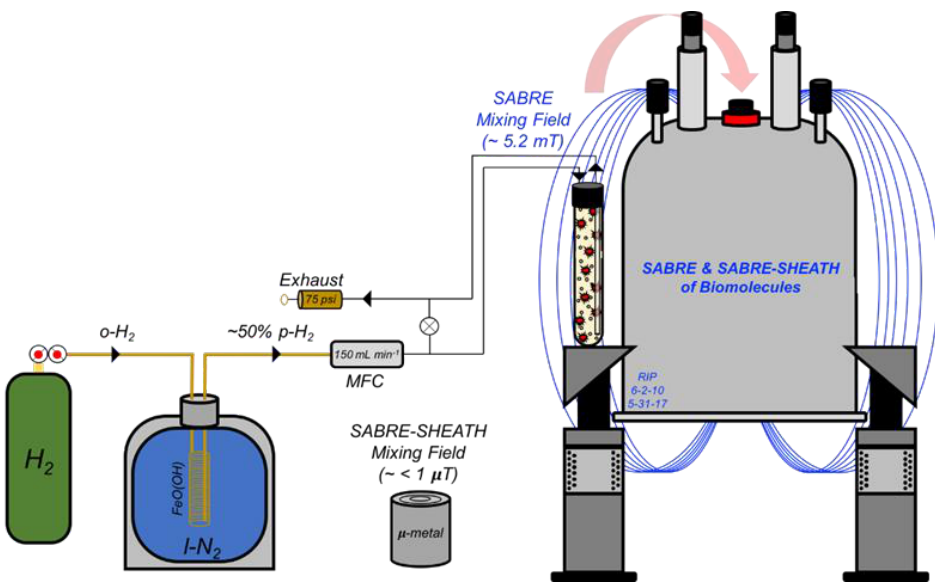
Figure 3. 1 H SABRE and 15 N/ 13 C SABRE-SHEATH setup (used for experiments at SIUC). Hydrogen gas (H 2 ) from a cylinder (with initial p -H 2 fraction of 25%) is passed over a catalyst bed of FeO(OH) cooled in liquid nitrogen for ~50% conversion to p -H 2 . A mass flow controller (MFC) at 150 mL min −1 allows for the precise regulation of p -H 2 bubbling rate within the NMR tube; pressure was typically maintained at 75 psi. 1 H SABRE and 15 N/ 13 C SABRE-SHEATH experiments were performed by bubbling p -H 2 through the sample while placed in either the NMR magnet’s fringe field (~5 mT) or a mu-metal magnetic shield (~1 µT), respectively, prior to rapid manual transfer of the sample to the 9.4 T magnet for high-field detection.